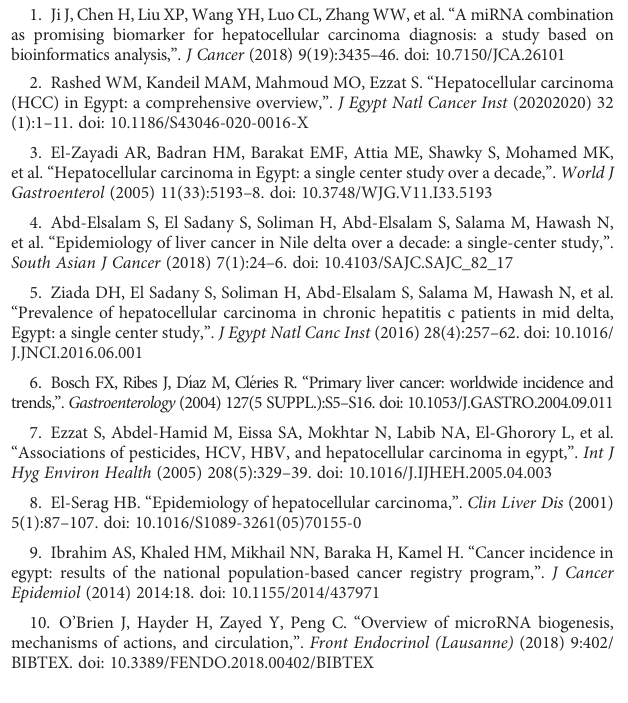
SUPPLEMENTARY FIGURE 2 Comparison between our data and different data set merged and clustered in